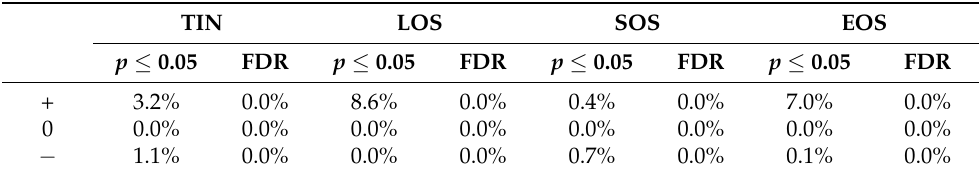
Table A2. Forest area with trends in growth, expressed as percent forest area within each ecoregion. Areas are presented as area of statistically significant trends ( p ≤ 0.05) and statistically significant trends after correction for false-discovery rate (FDR). We used linear regression to identify annual trends in forest growth indices over the course of the 26-year study period. Time-ordered datasets for each forest pixel were first pre-whitened using the Yue-Pilon method [73]; wherein the series was transformed by subtracting the first autoregressive component from the series in order to remove temporal autocorrelation and avoid Type-1 error in trend testing [74]. Linear models were then fit using Sen’s slope [75], with the forest growth variable as the dependent variable and time (i.e., year) as the independent variable. The significance of models was assessed using p -values from a two-tailed Mann-Kendall significance test [76]. Testing many spatial pixels simultaneously presents a multiple-testing problem, wherein there was essentially a guarantee that false-positives would be identified without appropriate correction [77]. To address this, we adjusted p -values to account for the false-discovery rate using the Benjamini and Hochberg method [78]. Trend tests were performed using the zyp package for R